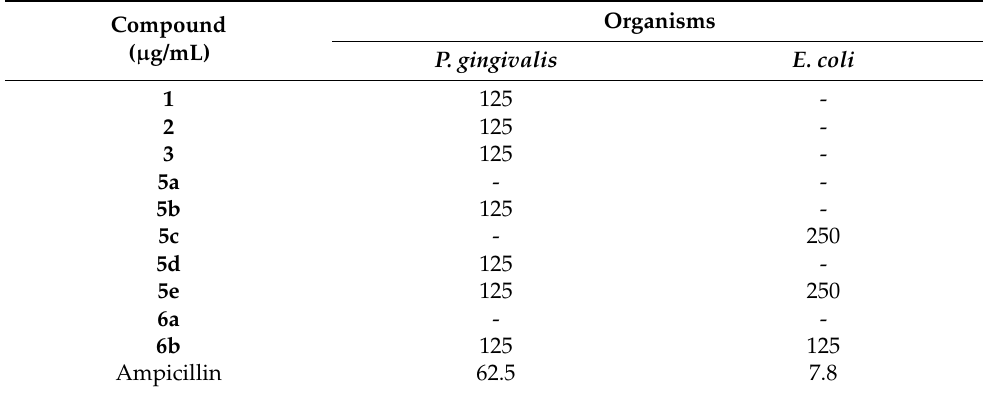
Table 2. MBC values of synthesized compounds